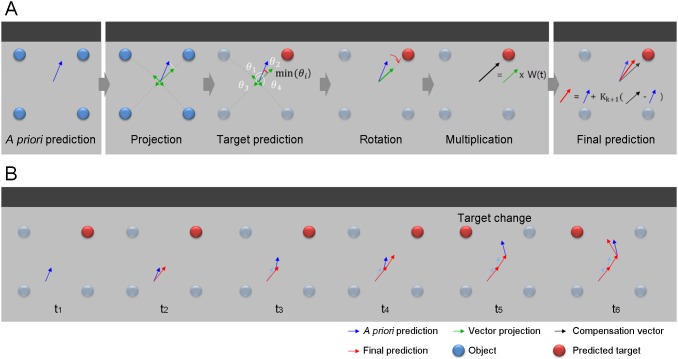
Principle of the FPA.(A) Three steps of the FPA. Step 1, the next movement state is a priori predicted from the present state and the neural activity. Step 2, the a priori predicted vector is projected onto the vectors directed from the present position to each object (green arrows are vector projections). One of the objects is predicted as the target which has the minimal angle between the predicted vector and vector projections (the red sphere). The predicted vector is rotated toward the target and multiplied by a weight value (black arrow) to magnify the predicted vector to easily reach the target. Step 3, the final prediction vector (red arrow) is determined from a priori prediction and the compensation vector. (B) Prediction example while changing a target. The example shows how a target and final prediction can be changed according to the direction of a prior prediction.